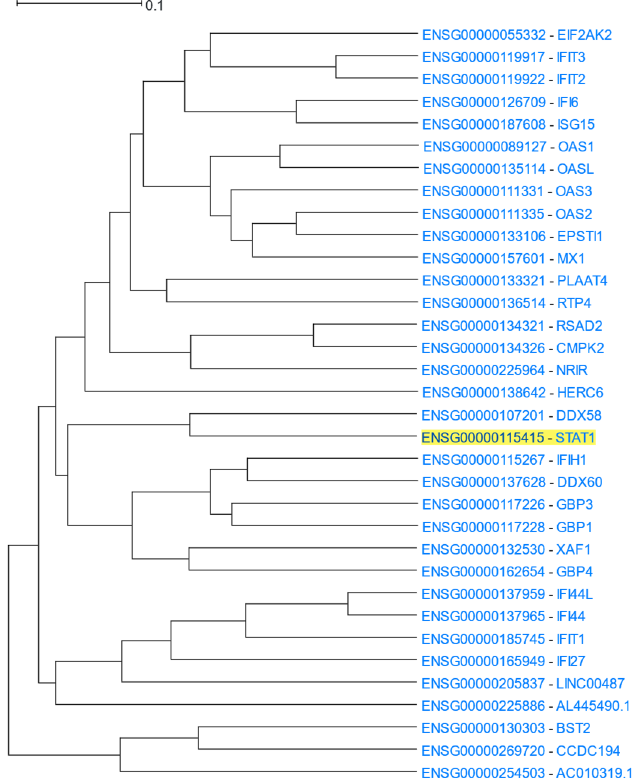
Figure 6. HGCA2.0 STAT1 5 internal node coexpression clade. Table 5. Selected top gene term enrichments of the coexpressed genes to STAT1 in HGCA2.0.